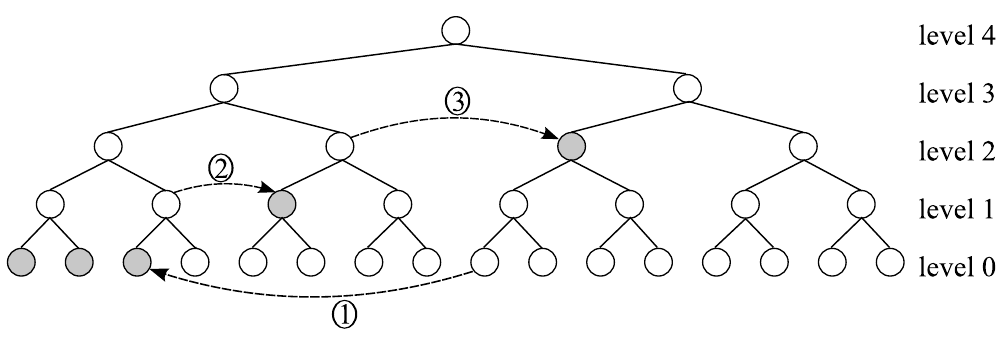
Figure 6. Transformation from a semi-compact assignment to a compact